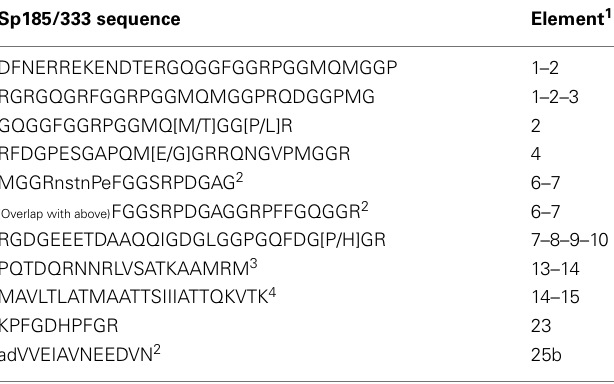
Table 1 | Mass spectrometric identification of native Sp185/333 proteins from coelomic